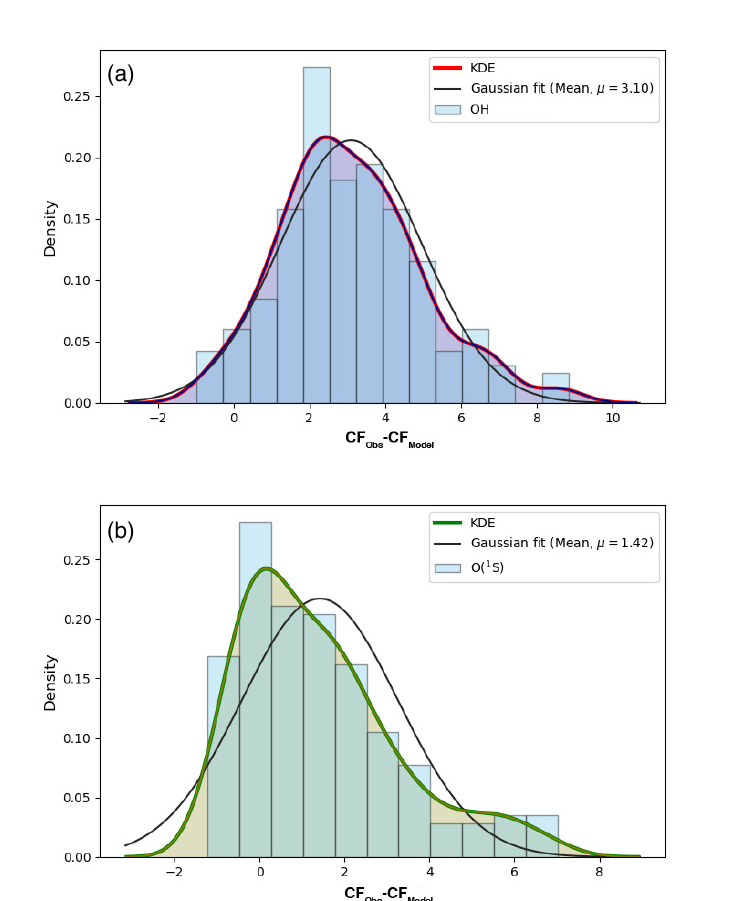
Figure 4. Histograms of the residuals and density plots for the ( a ) OH and ( b ) O ( 1 S )